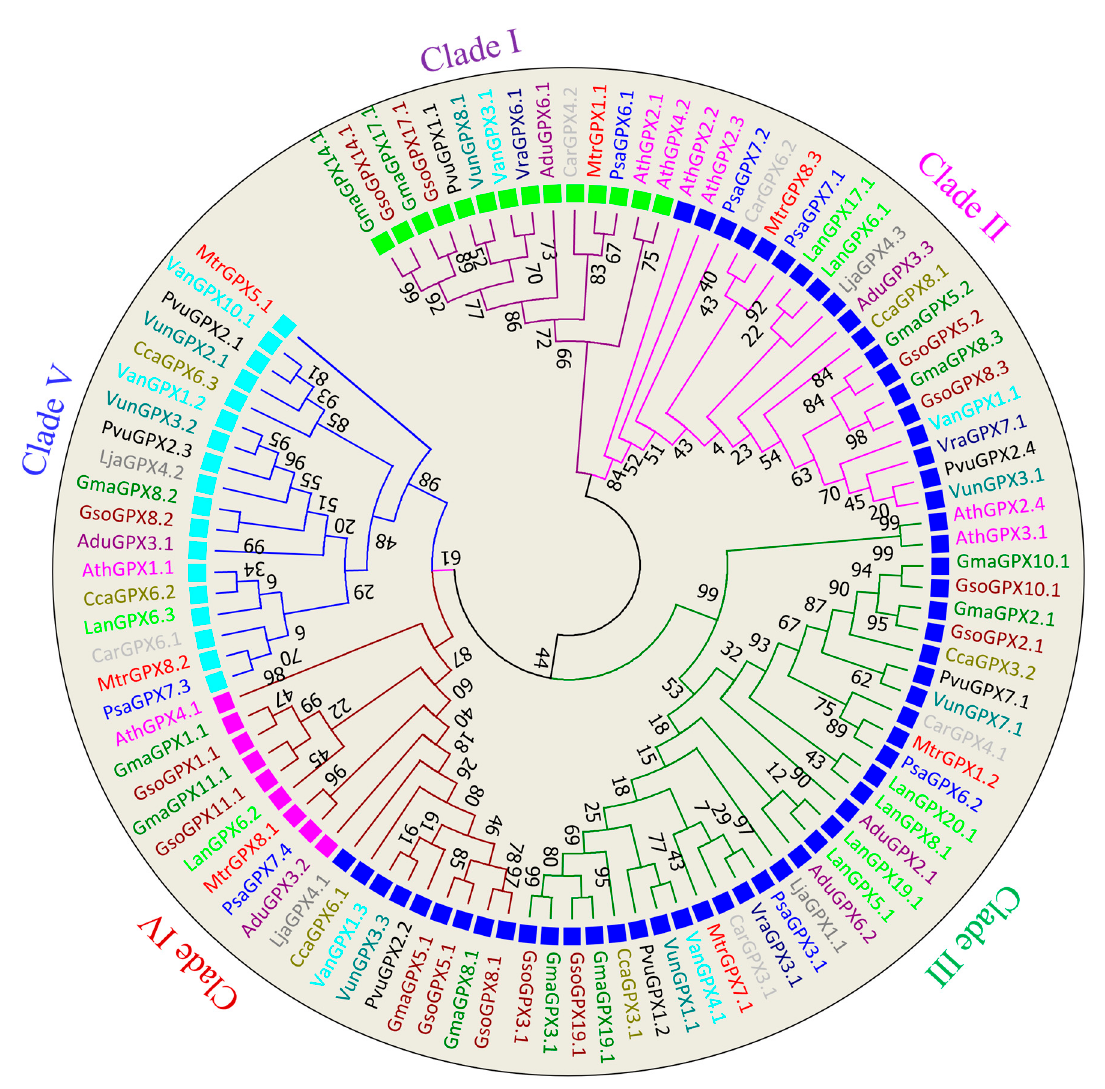
Figure 2. Phylogenic tree of GPX proteins. The tree was constructed in MEGA 7 by using the neighbor-joining method with 1000 bootstraps. Different clades of tree are marked with different colors of branch lines: Clade I (red), Clade II (pink), Clade III (green), Clade IV (mahroon) and Clade V (blue). The square shaped boxes represent the cellular localization: aqua (peroxisome), blue (cytoplasm) and green (chloroplast) and pink